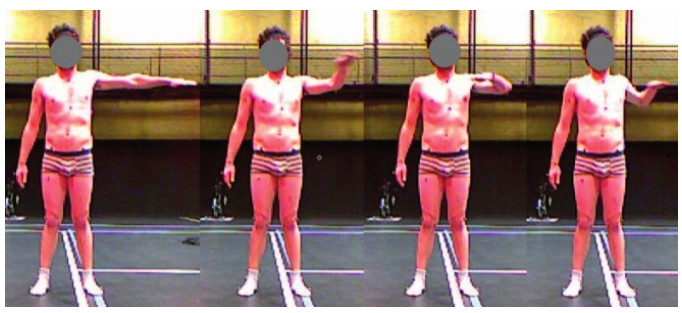
Figure 3. Examples of movement performed by the subject with 0° of